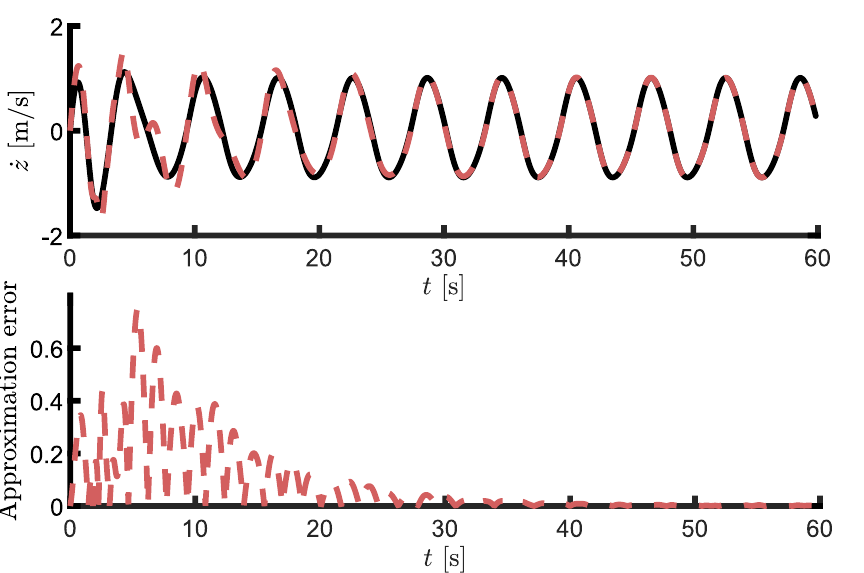
Figure 10. ( Top ): Output traces for target point absorber system (solid-black), and the computed approximating model by moment-matching (dashed-red). ( Bottom ): Error between target and approximating response as a function of time.